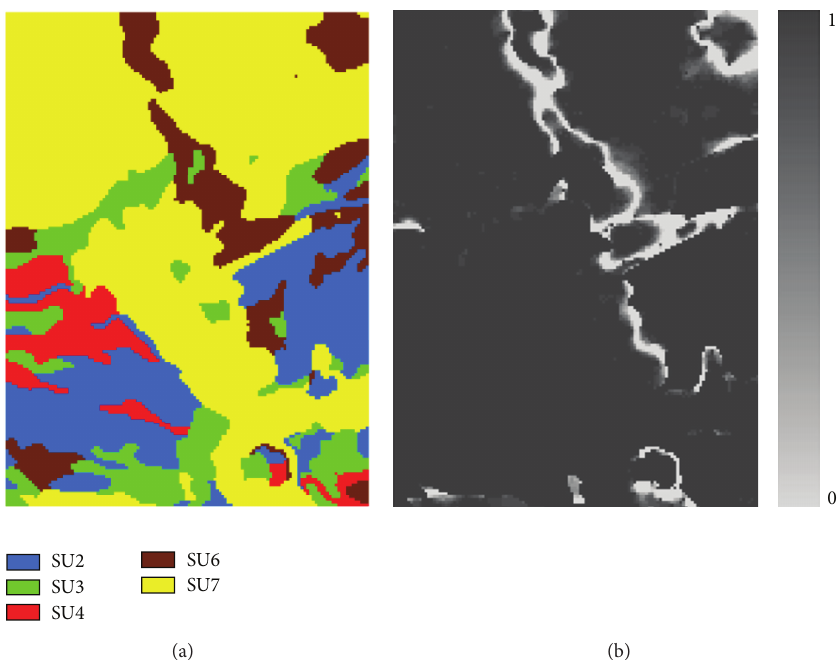
Figure 5: The optimal prediction map (a) and the maximum occurrence probability map (b) of updated soil series conditioned on sample data and the legacy soil map using the Co-MCSS method.